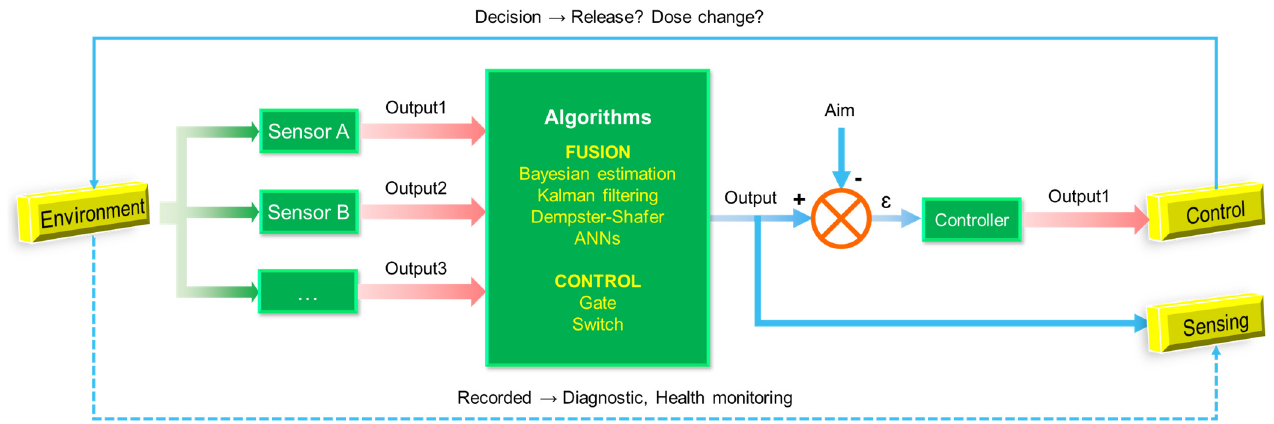
Figure 5. Scheme of a prototype for the next generation diagnostics.